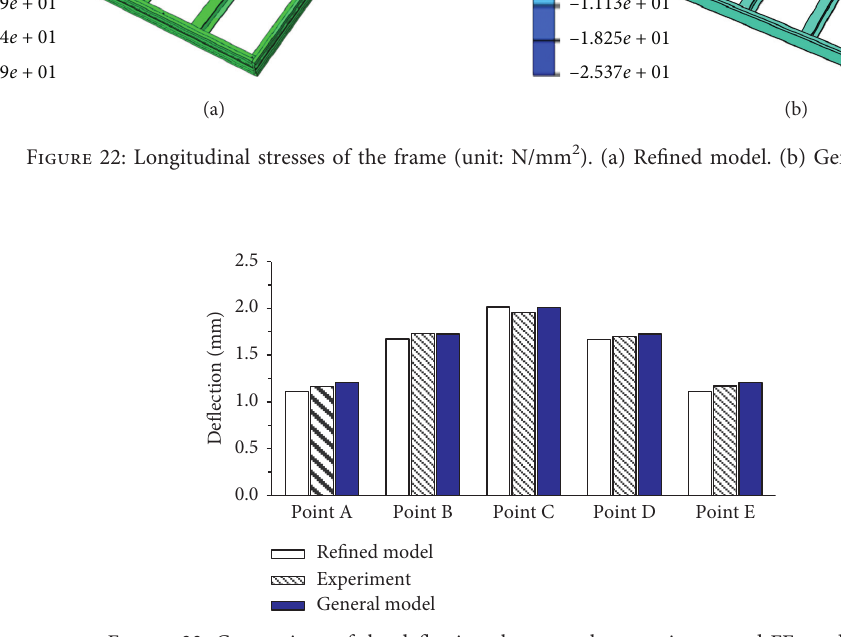
Figure 23: Comparison of the deflections between the experiment and FE models.